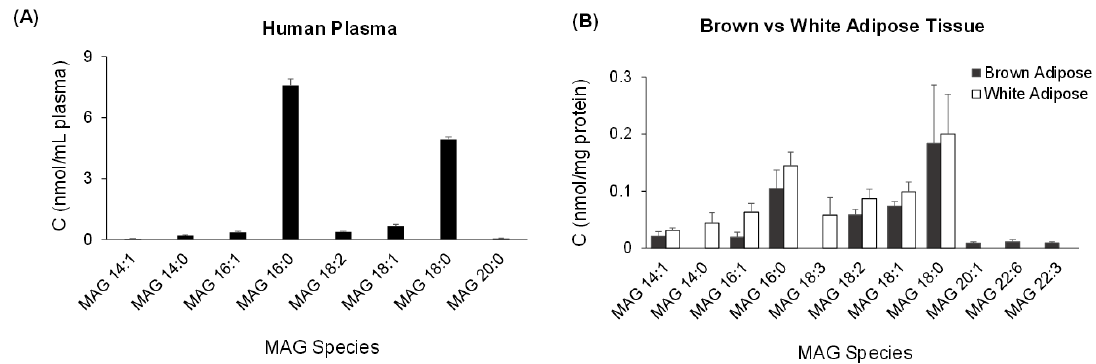
Figure 10. Profile of MAG molecular species obtained from ( A ) human plasma and ( B ) mouse brown and white adipose tissue samples. The data represent means ± S.E. of n = 6 mice and 6 replicates of human plasma. The full high-resolution MS and MS/MS data were collected using the MS/MS ALL mode under the following conditions: GS1 = 10, GS2 = 10, CUR = 15, Temp = 300 °C, DP = 100 V, CE = 15 ± 10 V. The neutral loss scan MS/MS spectra was generated from the collected data retrospectively.